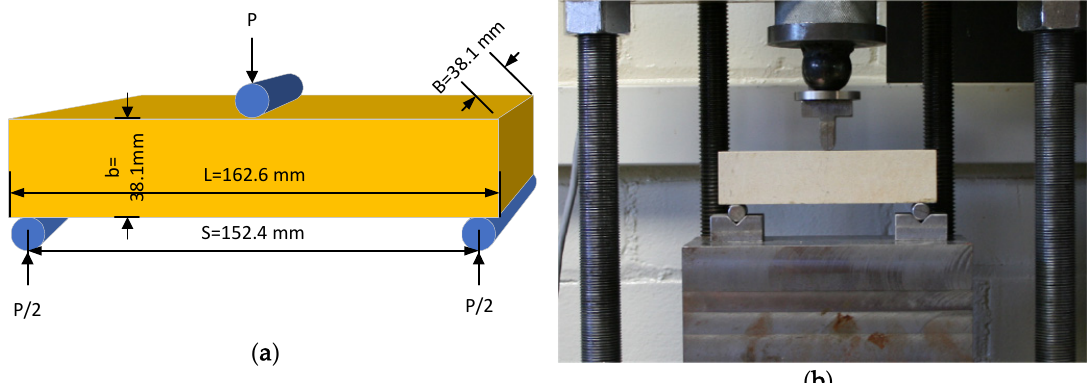
Figure 3. Three-point flexural test: (a) specimen geometry; (b) test set-up.